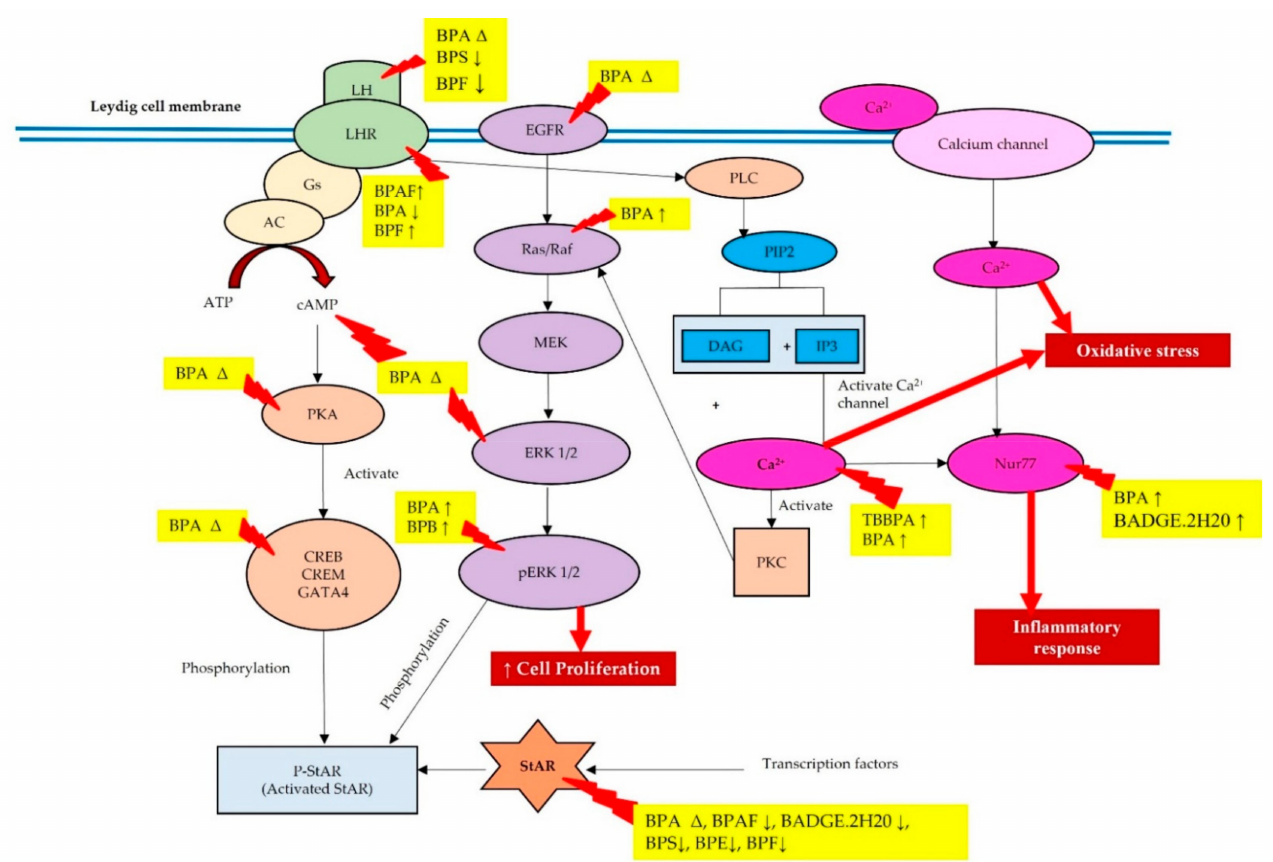
Figure 2. The effects of BPA and its analogues targeting the three signaling pathways in regulating the StAR gene and protein expressions. Abbreviations: ↑ , increase; ↓ , decrease; ∆ , changes (can be increase or